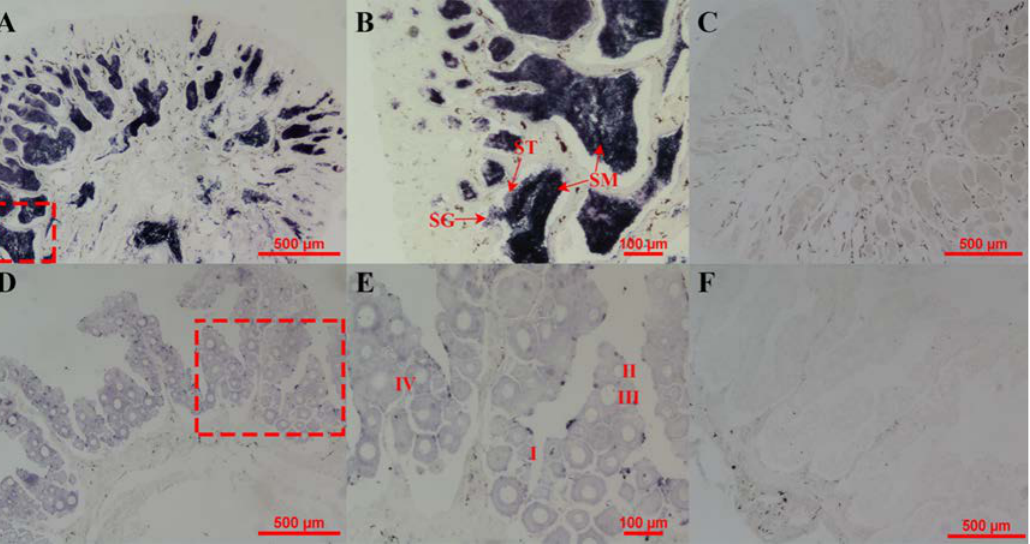
Figure 4. Relative expression of cyp26b1 in Chinese tongue sole tissues. ( A ), relative expression of cyp26b1 in different tissues. ( B ), relative expression of cyp26b1 in various development stages. Values are indicated as means ± SEM (N = 3). ‘*’ refers to statistically significant differences ( p < 0.05), and ‘**’ means very significant differences ( p < 0.01).